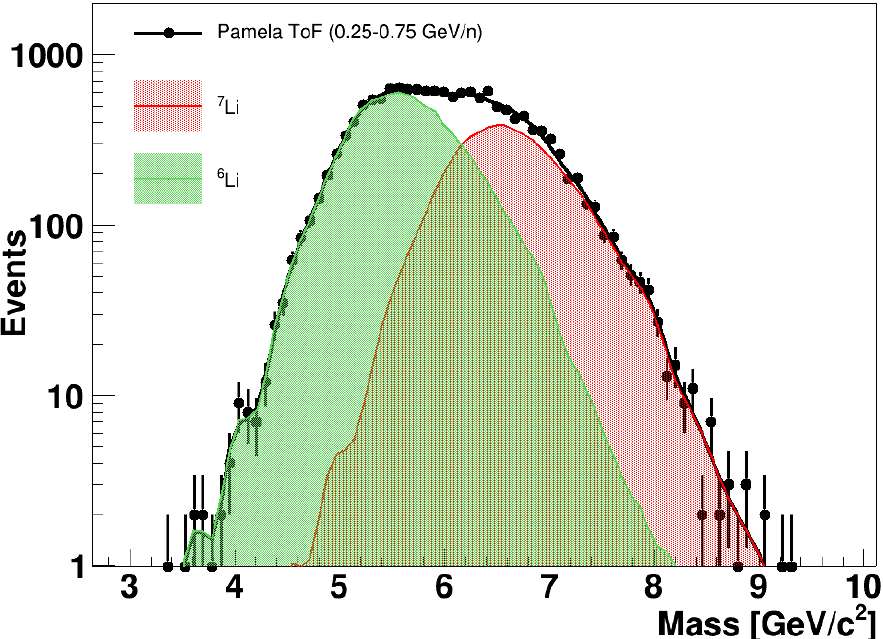
Figure 2. An example of lithium isotope measurements with the data-driven analysis of PAMELA- ToF data collected in the 0.25–0.75 GeV/n